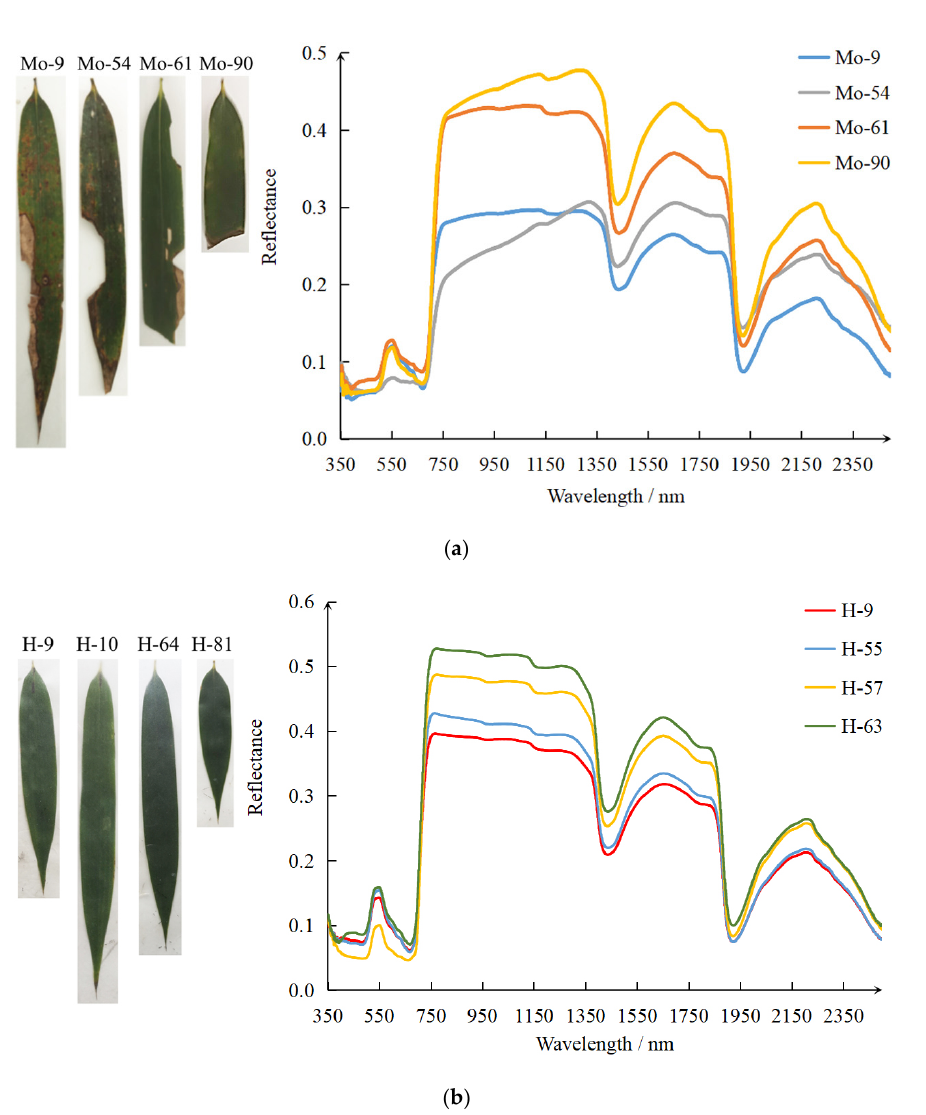
Figure 9. The pictures and the spectrums of selected leaf samples with different ratios of indentation and disease spots. ( a ) The damaged leaves with different ratios of indentation and disease spots. ( b ) The healthy leaves with a different spectrum.